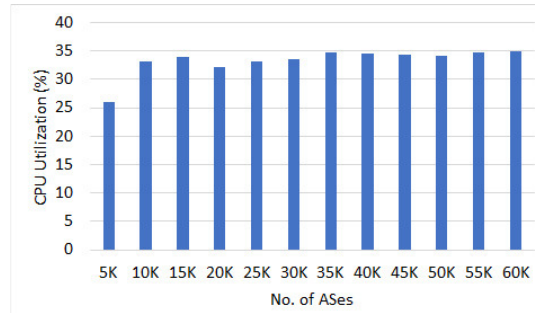
Figure 15. Avg. CPU usage (%).